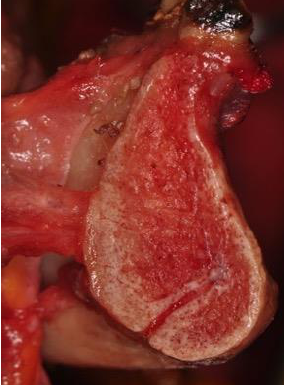
Figure 4. Anatomical picture of half of a mandible showing the nerve and artery to the mylohyoid entering the bone in the symphysis area.